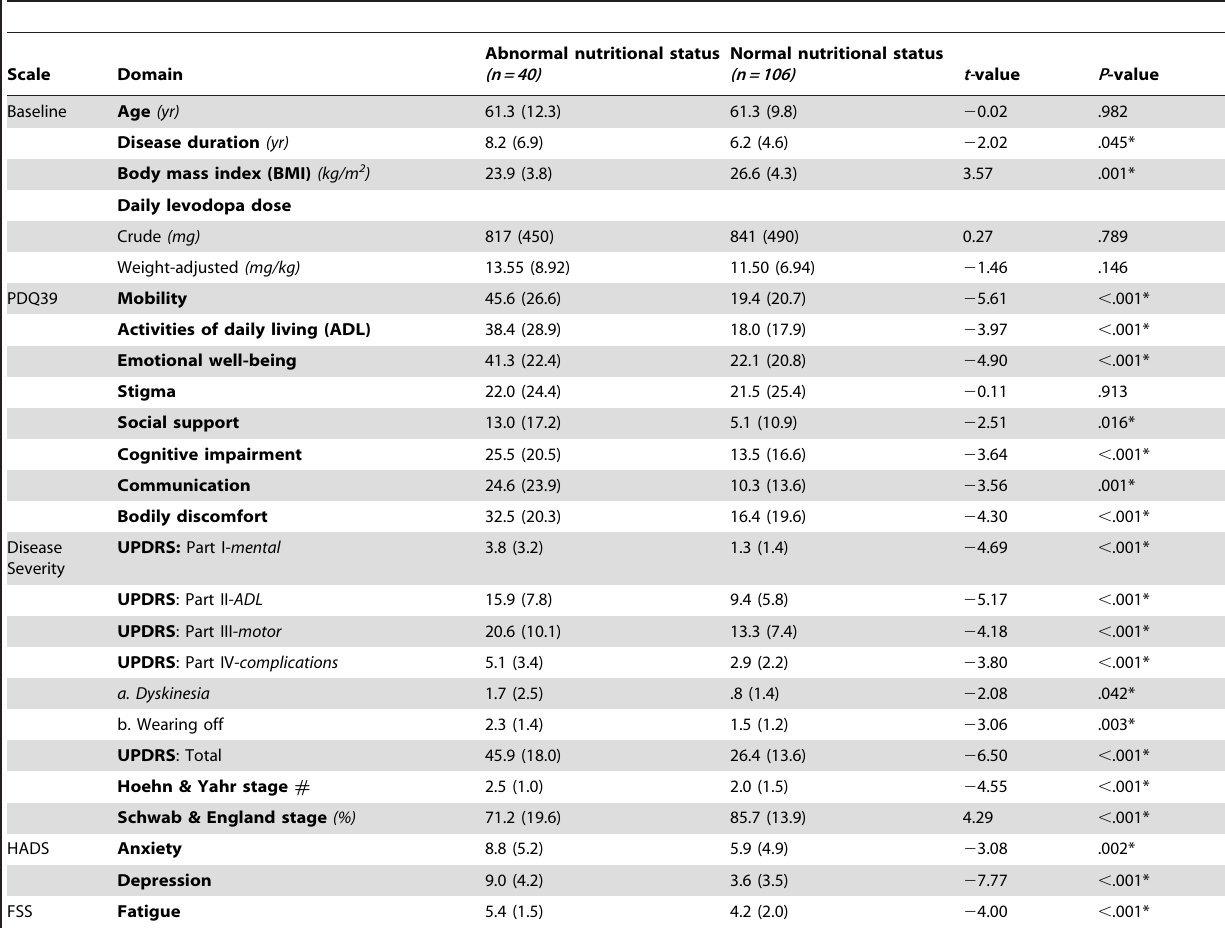
Table 4. Comparison of the mean [standard deviation (SD)] scores of different motor, psychiatric, fatigue and quality of life (PDQ- 39) scales between subgroups of Parkinson’s disease (PD) patients regarding nutritional status